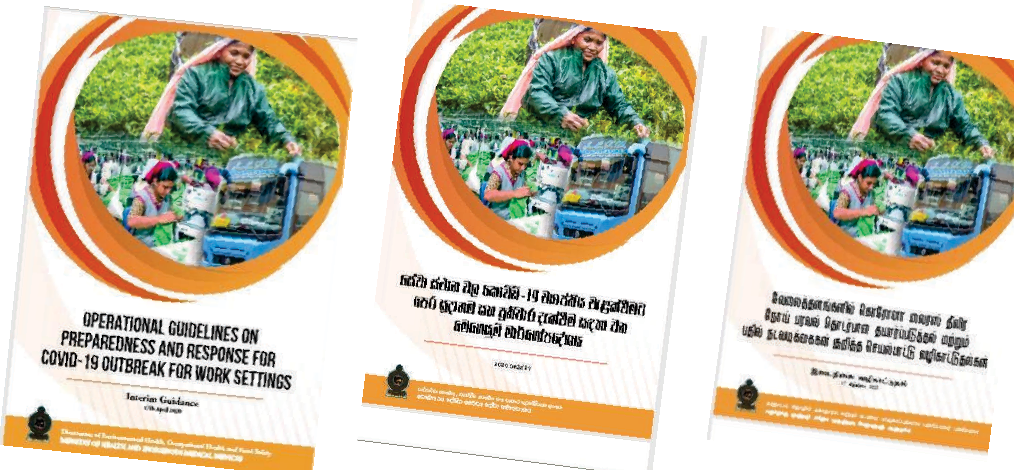
Figure 2: Cover of the book 'Operational guidelines on preparedness and response for COVID-19 outbreak for work settings' (English, Sinhala and Tamil